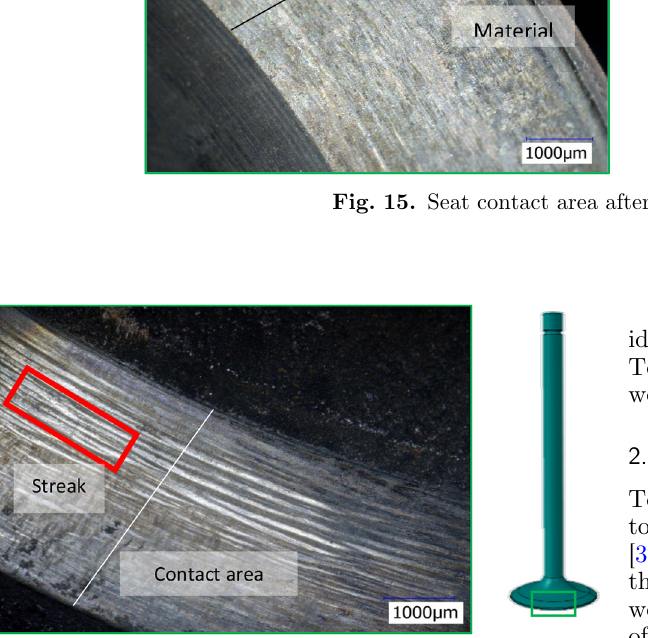
Fig. 16. Valve contact area after 1000 hours of